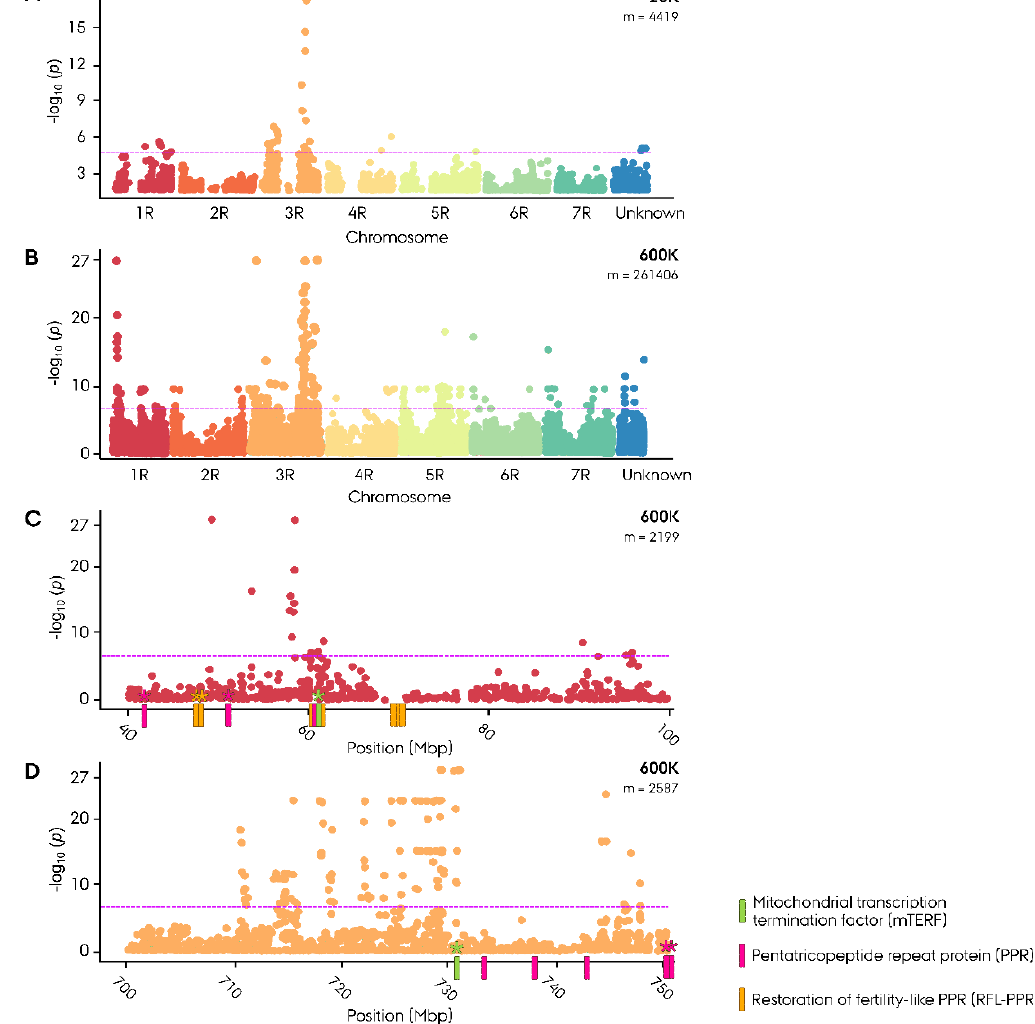
Figure 1. Manhattan plot for genome-wide association study (GWAS) on population origin (‘case control’) in Nordic Seed elite hybrid rye ( Secale cereale L.) breeding germplasm. ( A ) Genome-wise Manhattan plot of 20K SNP array GWAS ( n = 365). ( B ) Genome-wise Manhattan plot of 600K SNP array GWAS ( n = 180). ( C ) Manhattan plot of the 600K SNP array 1RS region. ( D ) Manhattan plot of the 600K SNP array 3RL region. Position of major restoration of male fertility-associated genes has been included with genes expressed in G-type hybrids marked with an asterisk. Significant association was identified using criterion of − log 10 ( p ) > 4.95 in 20K and >6.72 in 600K depicted as a magenta line.